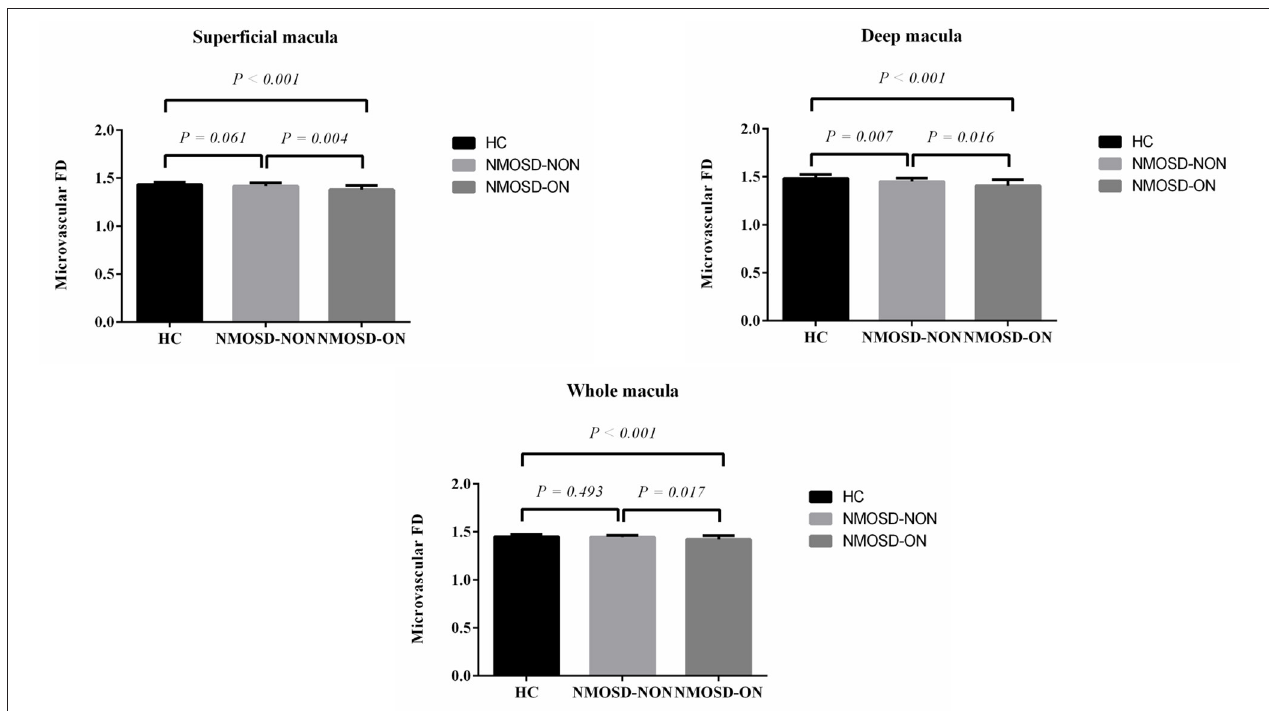
FIGURE 2 | Comparison of macular FD among neuromyelitis optica spectrum disorder (NMOSD) eyes with and without optic neuritis and healthy controls (HC).